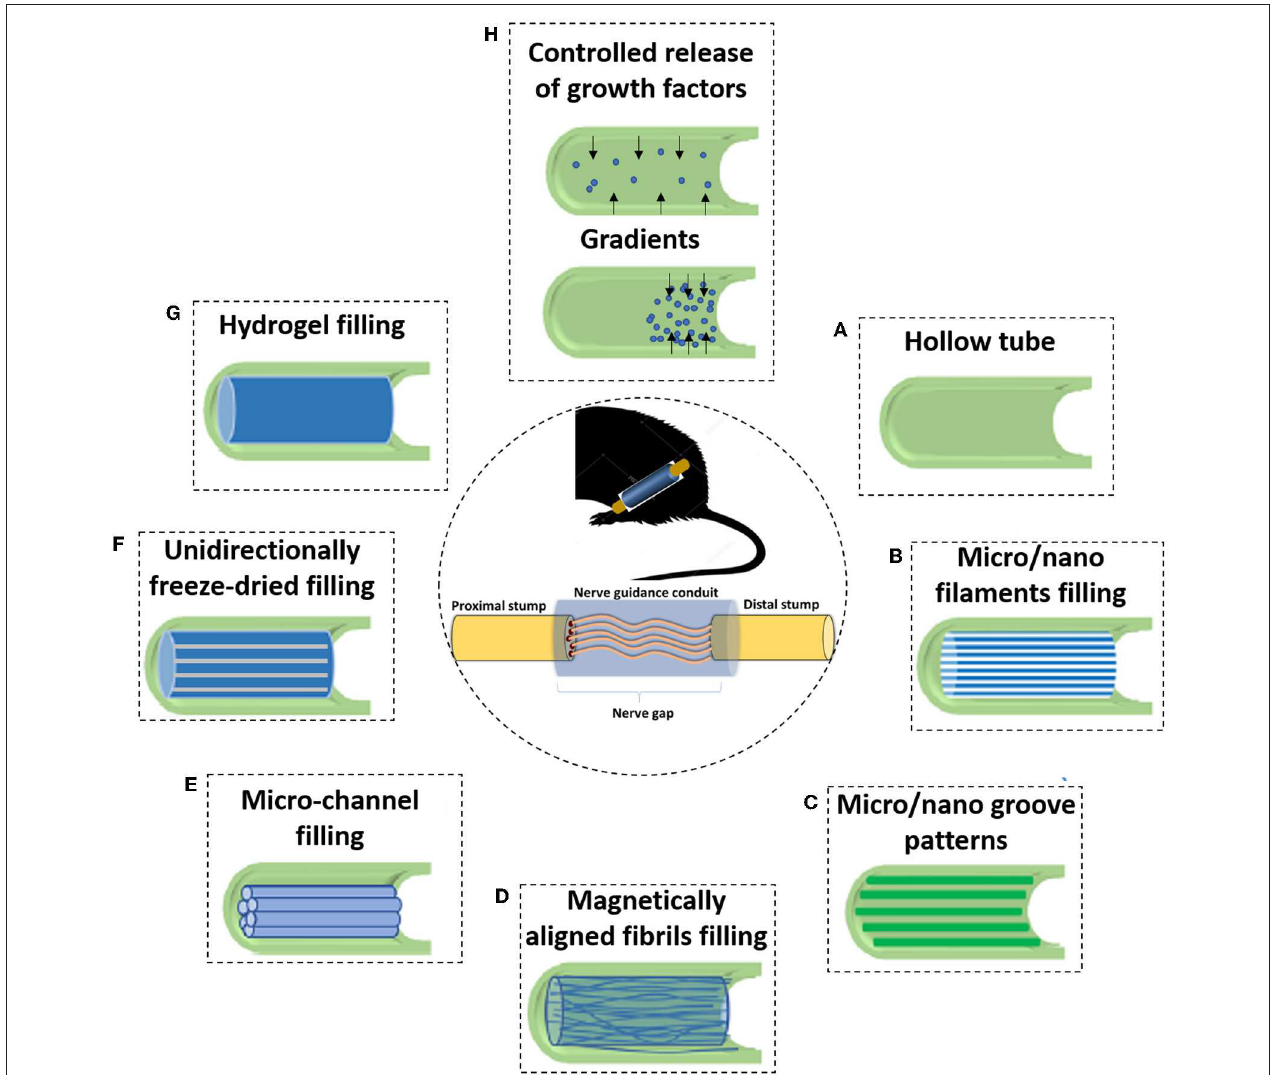
FIGURE 5 | Due to the incapacity of hollow NGCs to bridge larger nerve gaps, various filler materials and designs have been developed to enhance the performance of NGCs. (A) The initial strategy consisted of simple hollow NGCs; When considering luminal fillers, experiments suggested that the regenerating axons prefer aligned features rather than random orientation. Therefore, many of the approaches focus on obtaining an anisotropic topography. With this strategy in mind, many types of luminal matrices are considered (B) Micro- or nano- filaments resembling the structure of endoneurial tubes; (C) Micro/nano groove-patterns; (D) Magnetically aligned fibrils or cells; (E) Micro-channel filling; (F) Unidirectionally freeze-dried; (G) Another strategy consist in inserting permissive hydrogels as luminal fillers, being a soft support to regenerative axons; and (H) One branch of PNR research also focuses on the controlled delivery of growth factors. That can be achieved, for instance,